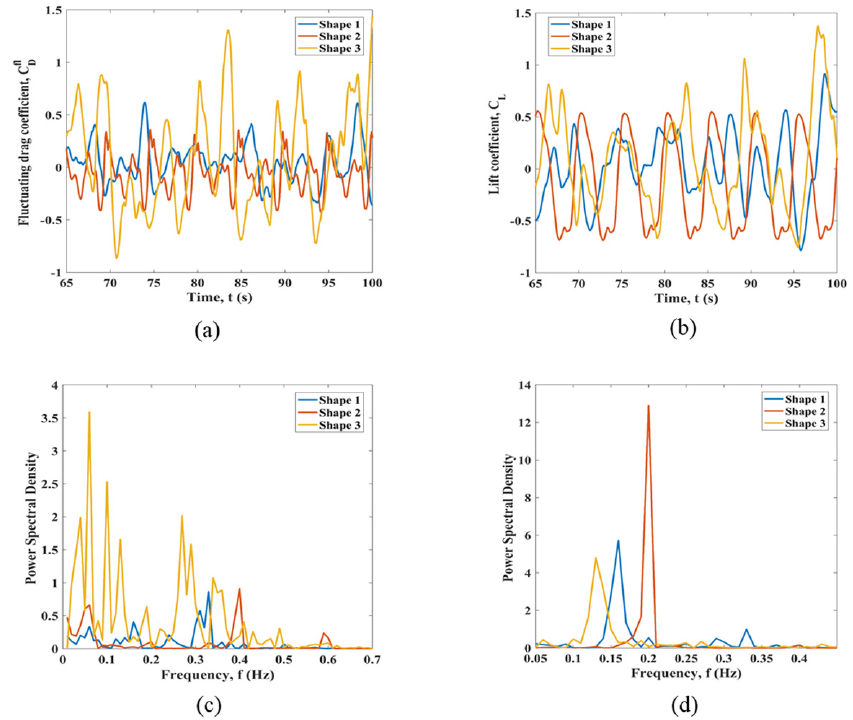
Figure A14. Fluid force coefficients for cylinder 5 immersed in uniform flow: ( a ) time history of the fluctuating drag coefficient; ( b ) time history of the lift coefficient; ( c ) the fluctuating drag coefficient FFT; ( d ) the lift coefficient FFT.